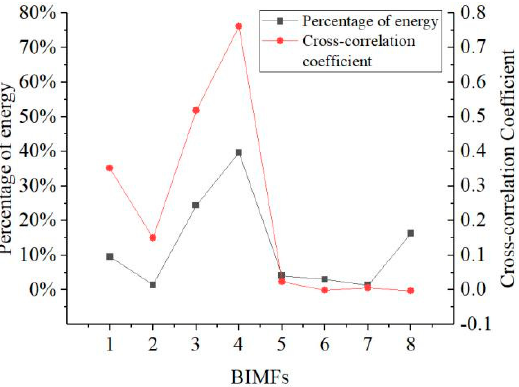
Figure 8. Energy weight and correlation of each BIMF and residual with the original image.